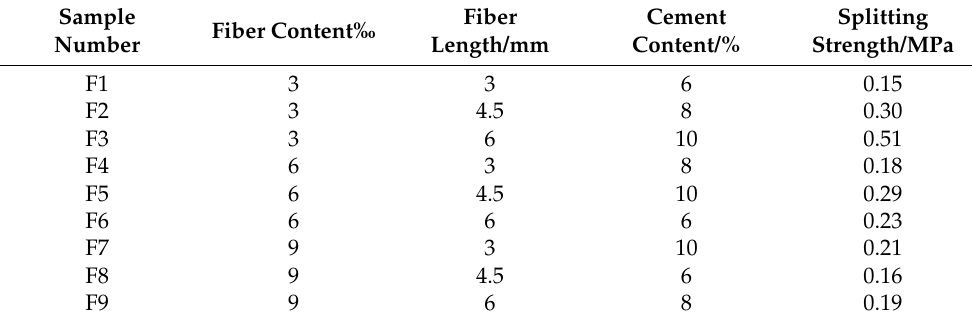
Table 4. Orthogonal test results.